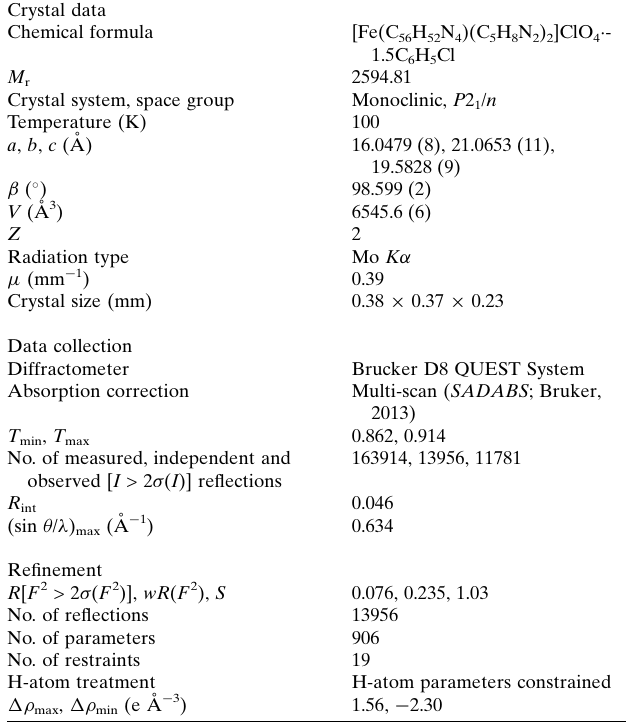
Crystal data Chemical formula